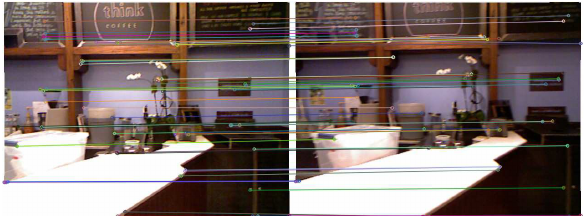
Figure 5. Divide image equally into 16 parts and extract feature points respectively